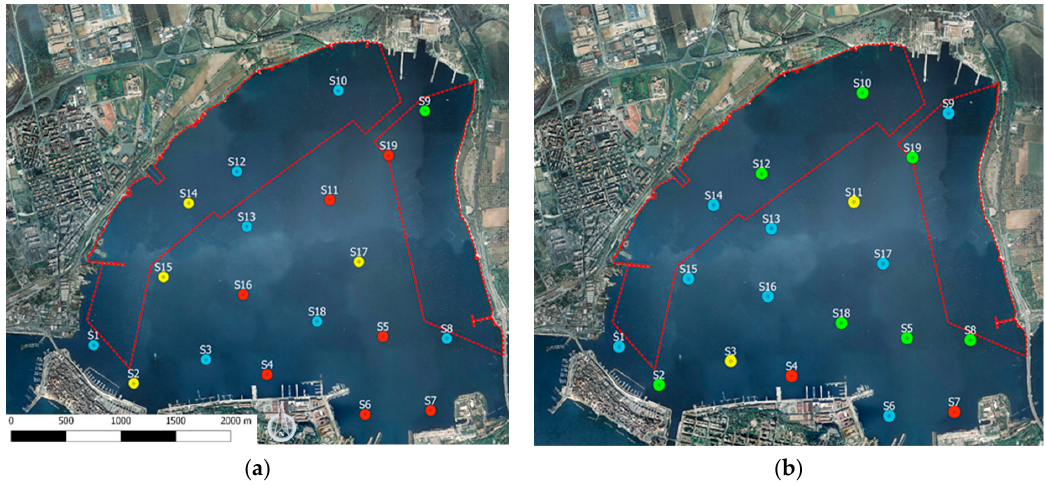
Figure 9. Area of investigation for the First Bay in the Mar Piccolo of Taranto in the sampling campaign in 2016 and spatial distributions of the Integrated Hazard Index (IHI): ( a ) 0.0–1.5 m below seafloor; ( b ) 1.5–3.0 m below seafloor. (Class of hazard:  Absent (IHI < 20);  Slight (20 < IHI <